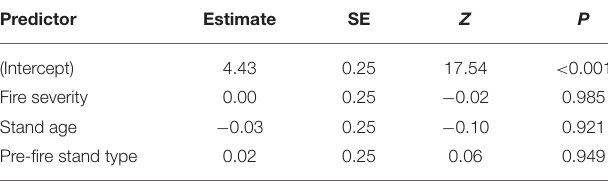
TABLE 2 | Summary of negative binomial mixed-effects model of relative abundance of seven heat-resistant fungi from 47 plots in boreal forests of the Northwest Territories, Canada.